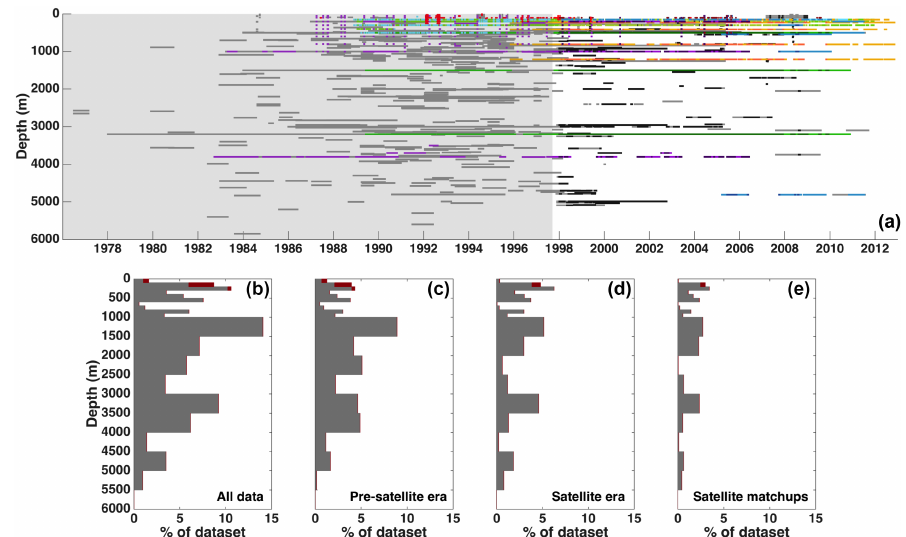
Figure 5. Depth distribution of POC flux observations. The percentage of total observations was binned every 100m in the upper 1000m and every 500m throughout the rest of the water column. Coloration is the same as in Fig. 2. (a) Temporal distribution indicates observations prior to (shaded area) and during (right panel) the satellite era. (b) The percentage of depth dinned total observations. (c) Observations prior to the continuous satellite era (before September 1997). (d) Observations collected during the continuous satellite era (beginning September 1997). (e) Observations with coincident satellite imagery within the same month of